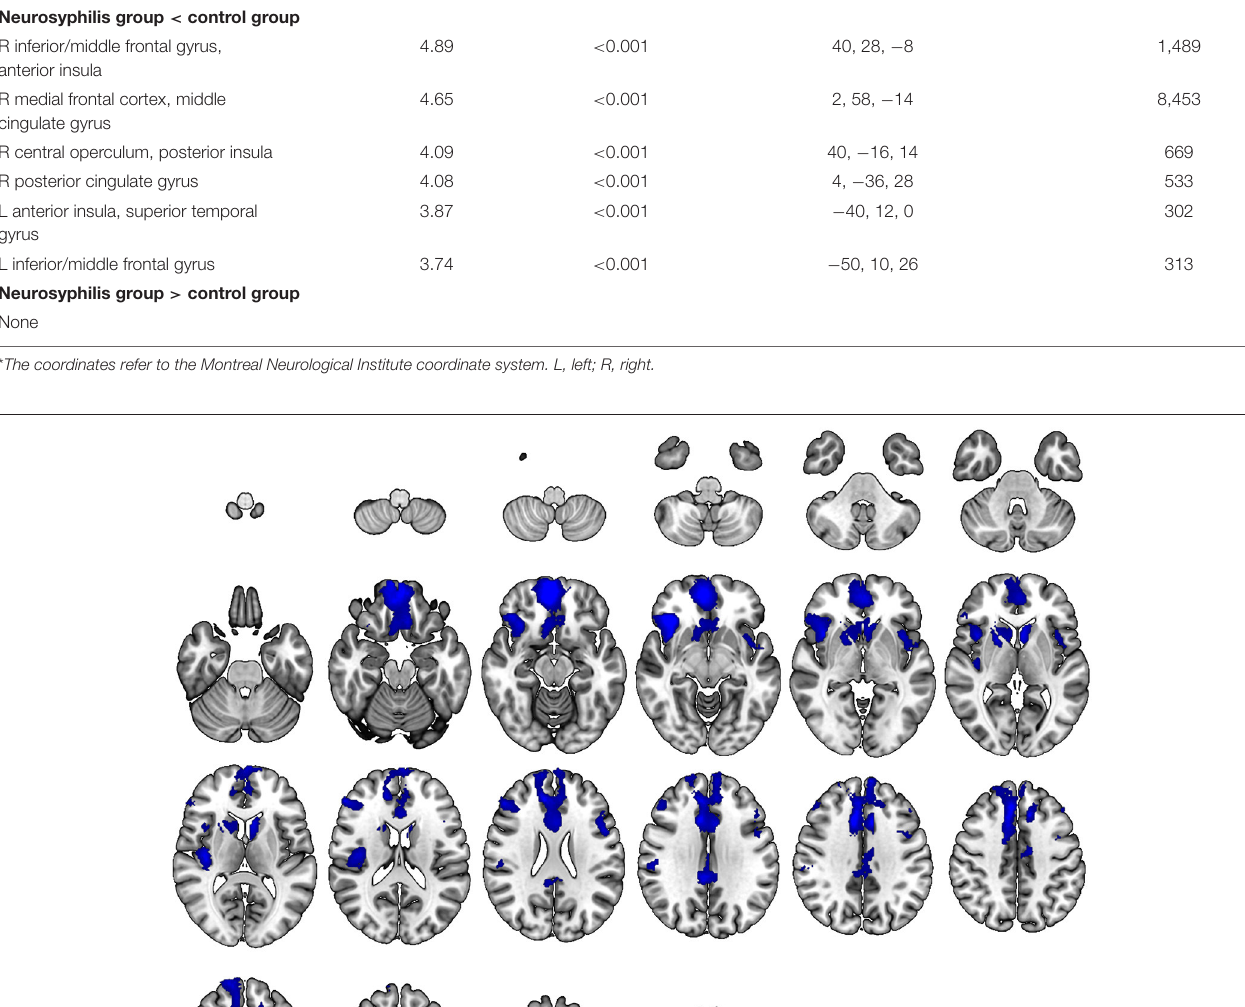
TABLE 2 | Differences in regional cerebral blood flow between patients with neurosyphilis and healthy controls. Region z p Coordinates* (x, y, z) Cluster size (voxels)